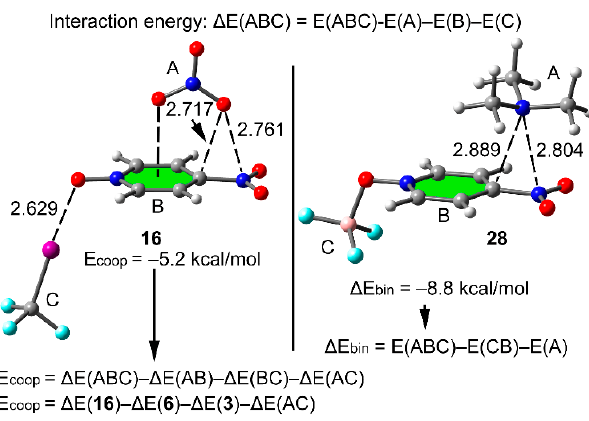
Figure 5. Optimized complexes 16 ( left ) and 28 ( right ). Distances in Å. The equations used to measure the cooperativity energies are also